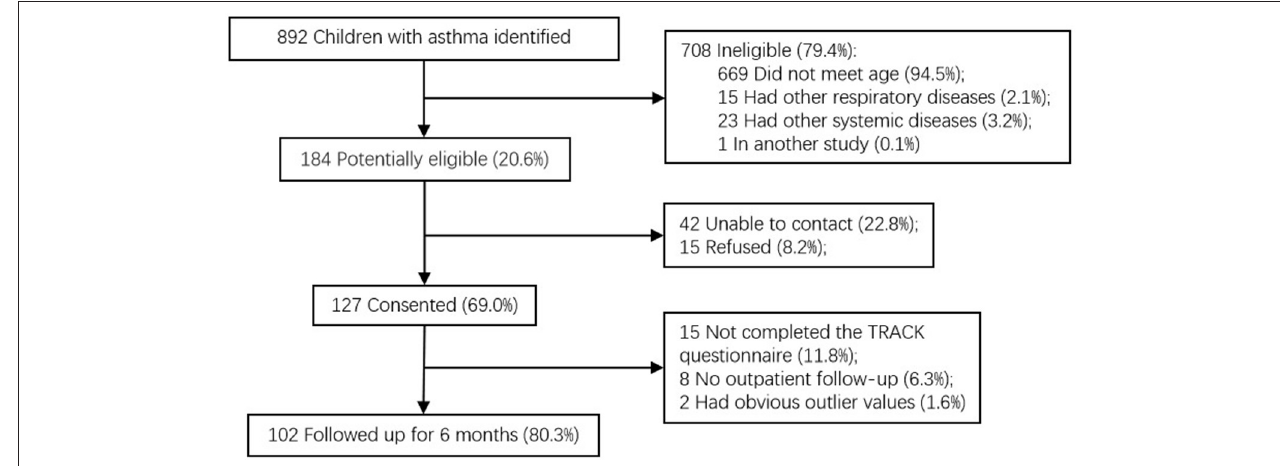
FIGURE 1 | Flow diagram for the selection of participants.